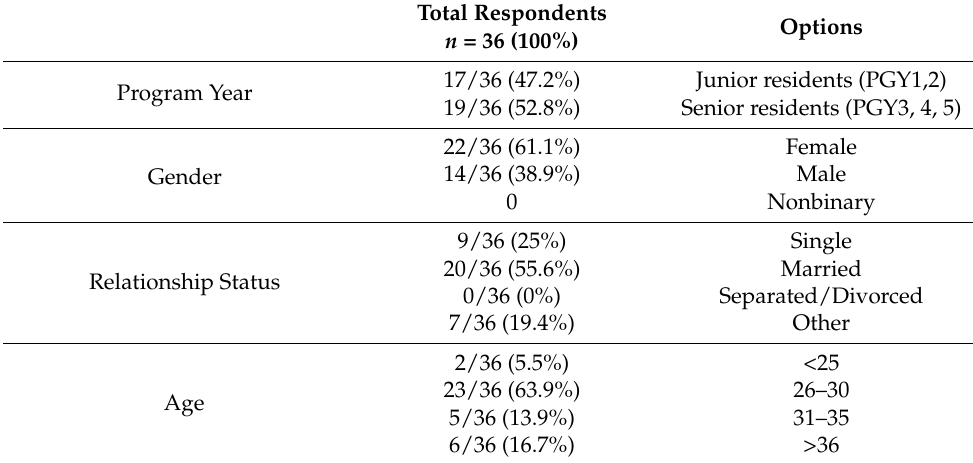
Table 1. Sample Characteristics, and Rural Experience, Interest and